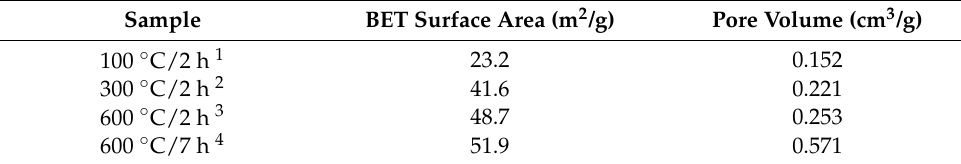
Figure 7. ( a ) N 2 adsorption and desorption isotherms and pore size distribution curves (inset) of all samples and ( b ) PL spectra for four samples at room temperature. Note: 100 °C/2 h, the precursor calcined at 100 °C for 2 h; 300 °C/2 h, the precursor calcined at 300 °C for 2 h; 600 °C/2 h, the precursor calcined 600 °C for 2 h; 600 °C/7 h, the precursor calcined 600 °C for 7 h. Table 2. BET surface area and pore volume of all samples.